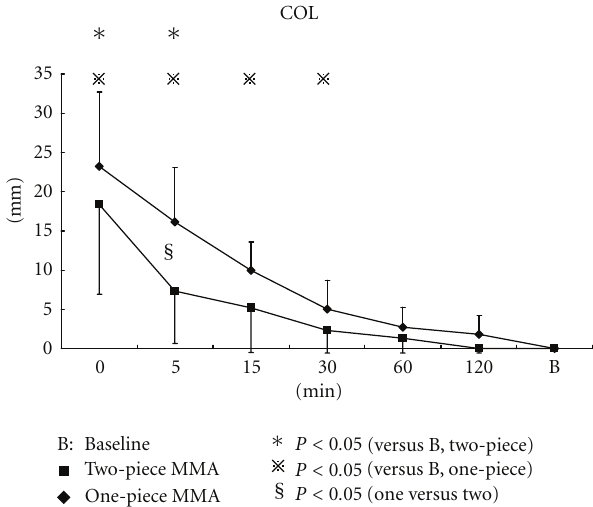
Figure 9: Changes in center of occlusal load after nocturnal use of di ff erent MAAs.